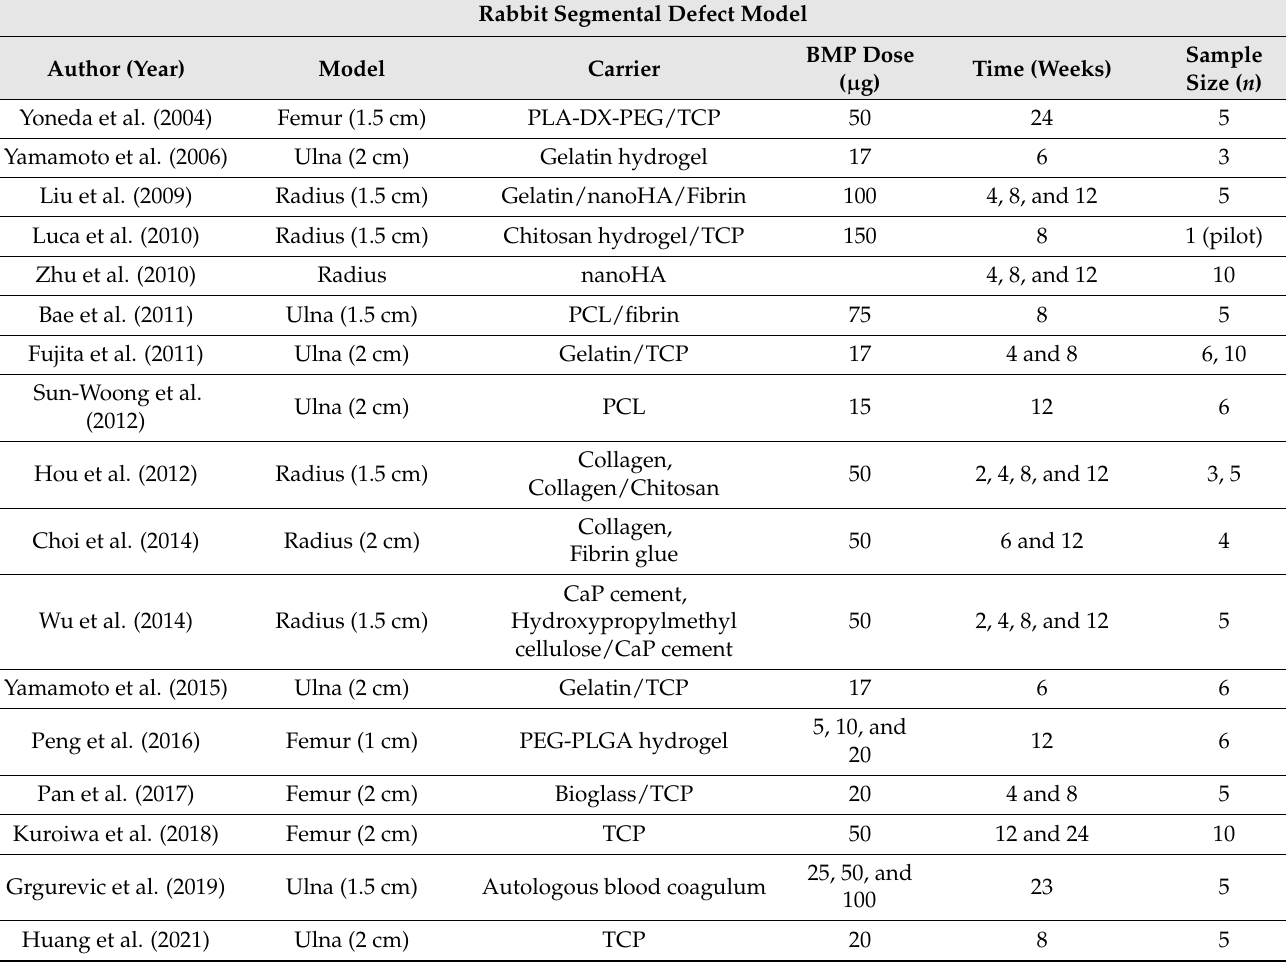
Table 3. Rabbit segmental defect model.